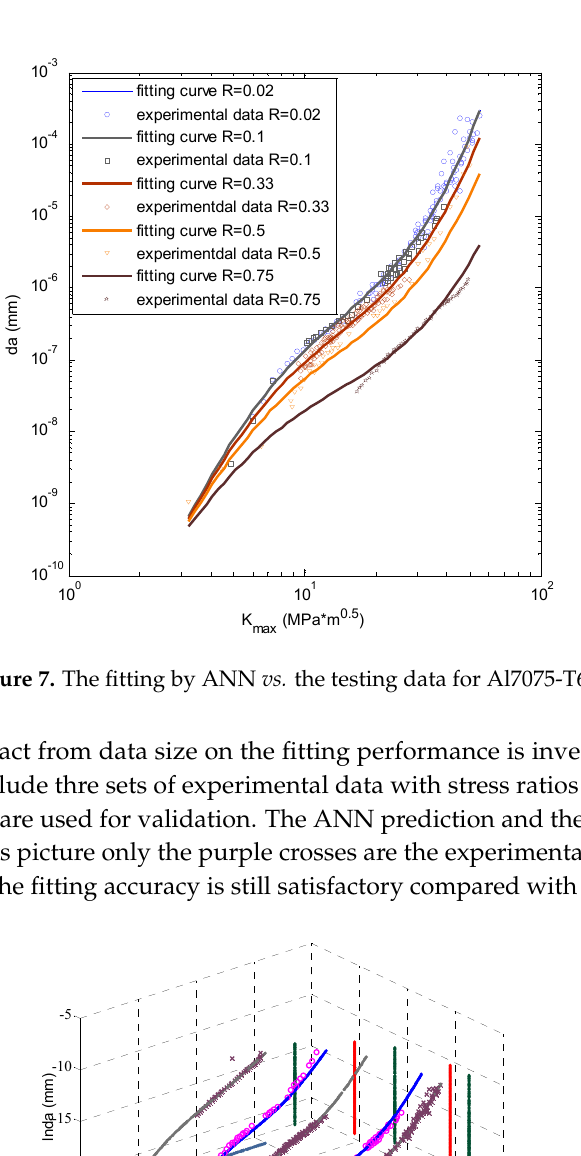
Table 2. The fitting indices of Al7075-T6.